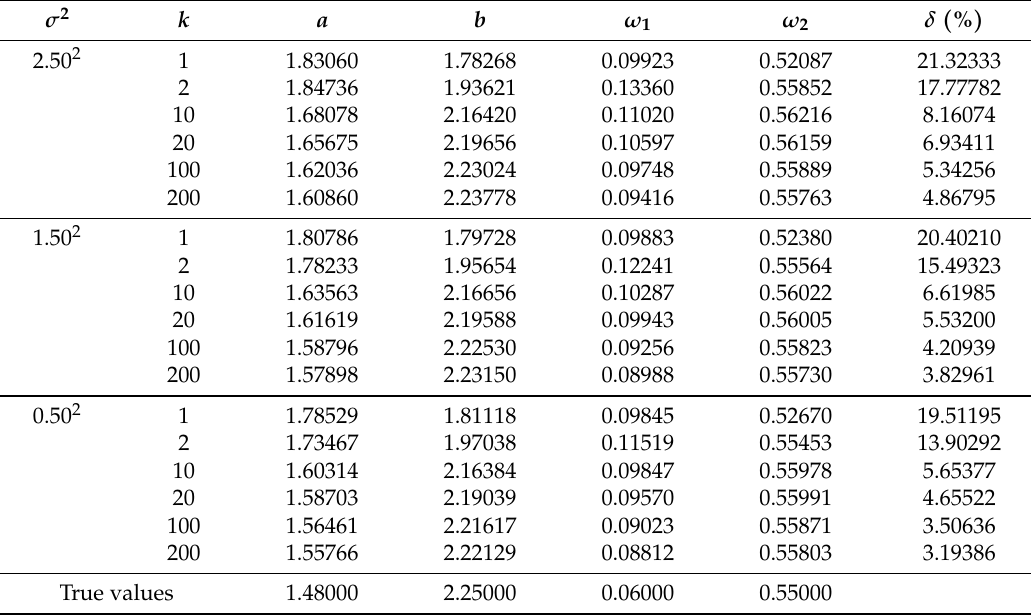
Table 2. The NI parameter estimates and errors.